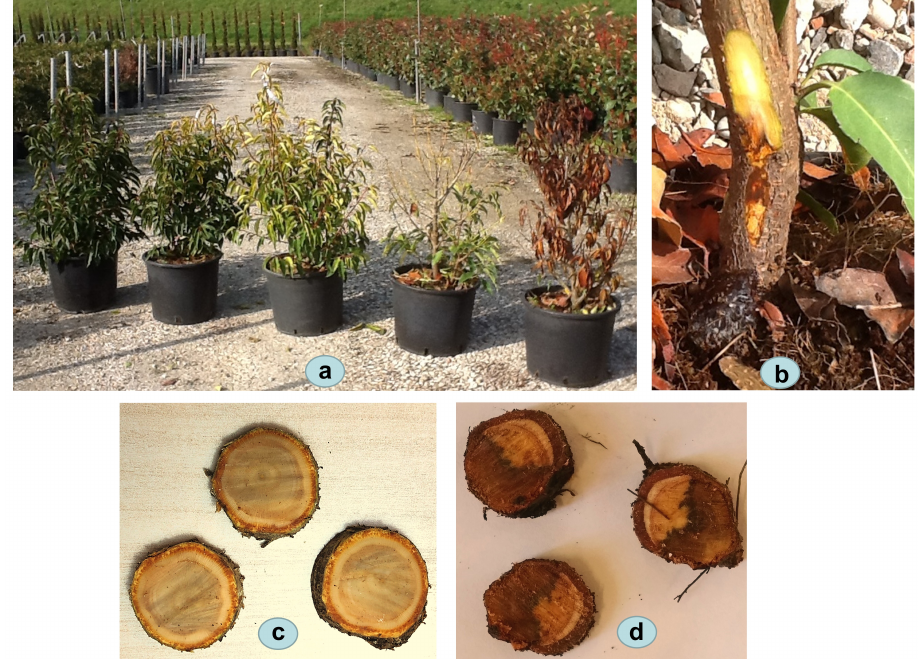
Figure 2. Symptoms associated with Prunus lusitanica dieback. ( a ) Three-year-old plants showing, from left to right, severe decline symptoms, including weak vegetation, yellowing, summer wilting and crown rot symptoms. A healthy plant is shown on the far left. ( b ) Part of the stem with bark removed, showing large reddish-brown areas along the stem beginning below the crown and running up along the stem. ( c ) Cross-sections of a healthy P. lusitanica stem. ( d ) Cross sections of an infected P. lusitanica stem revealed dark brown sectorial necrosis extending from the bark to the